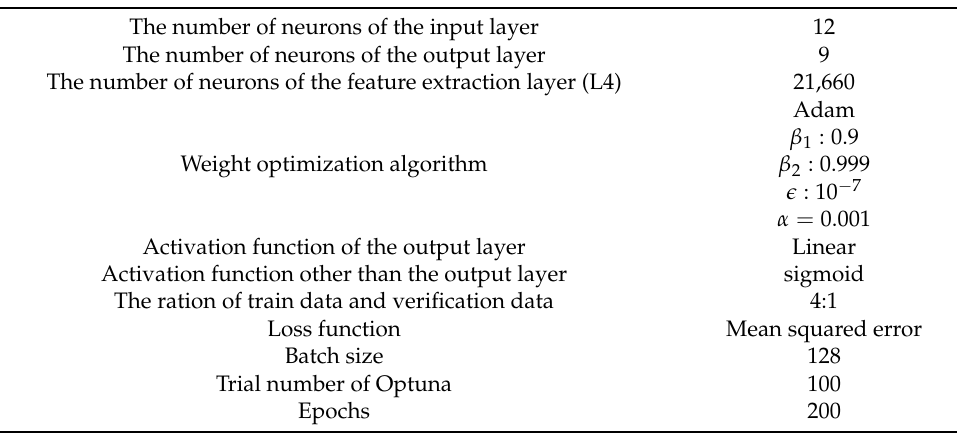
Table 4. Preset parameters for the tactile sensation estimation model. The number of neurons of the input layer The number of neurons of the output layer